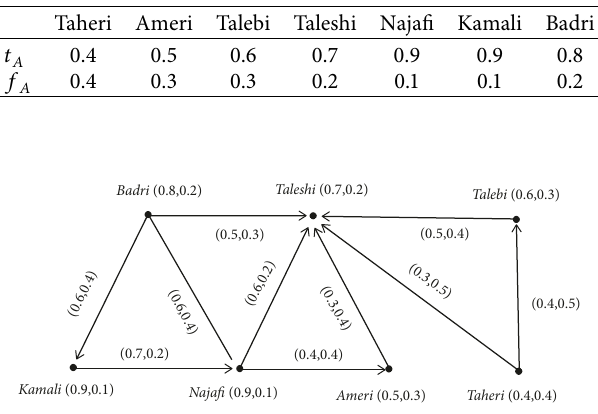
Figure 2: Vague graph X